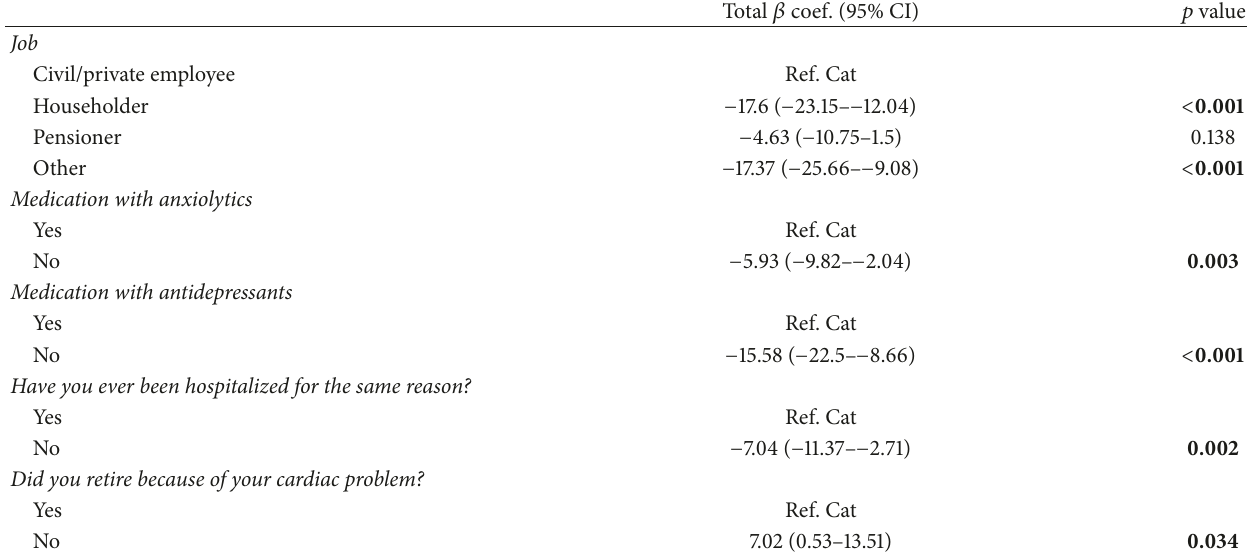
Table 6: Assessment of the effect of the factors on quality of